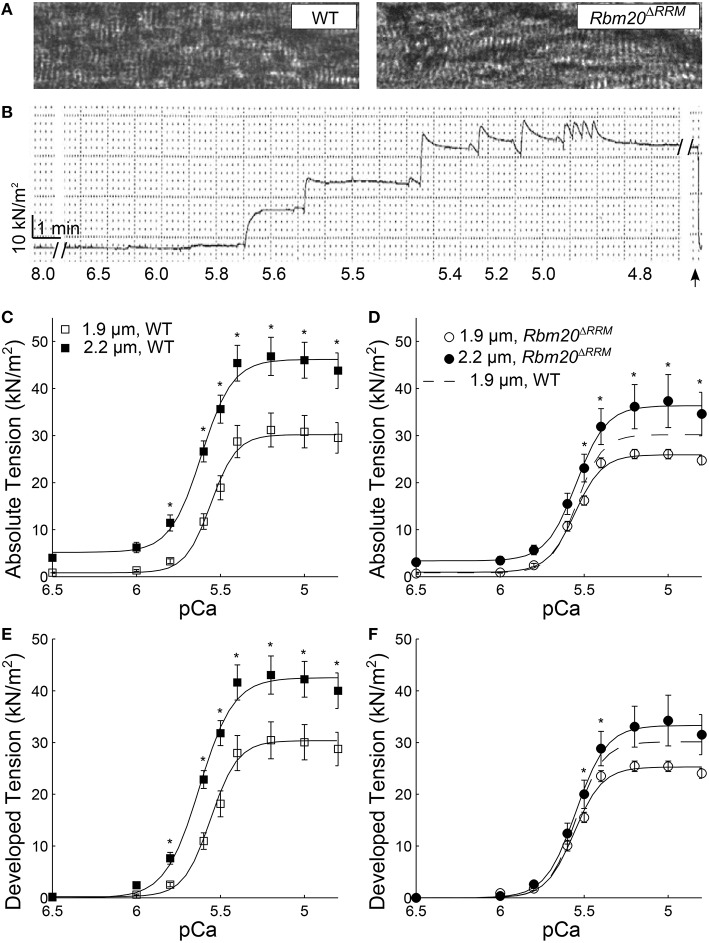
Tension-pCa relationships at long vs. short sarcomere length. (A) Example light microscopy images at 40X, showing skinned myocardial strips from WT (left), and Rbm20ΔRRM (right) mice. (B) An example absolute tension trace plotted against time from a myocardial strip that was Ca2+-activated from pCa 8.0 to 4.8 (pCa values listed below each solution exchange), where the strip was slacked (arrow) near the end of the experiment to ensure no baseline-tension changes throughout the time course of an experiment. Absolute tension-pCa relationships for (C) WT, and (D)
Rbm20ΔRRM mice and developed tension-pCa relationships for (E) WT and (F)
Rbm20ΔRRM mice at 1.9 and 2.2 μm sarcomere length. Solid lines represent 3-parameter Hill fits to the tension-pCa data, with the dashed lines representing the 1.9 μm sarcomere length fit for Rbm20ΔRRM replotted in panel (D,F). *p < 0.05 between sarcomere length within a genotype.